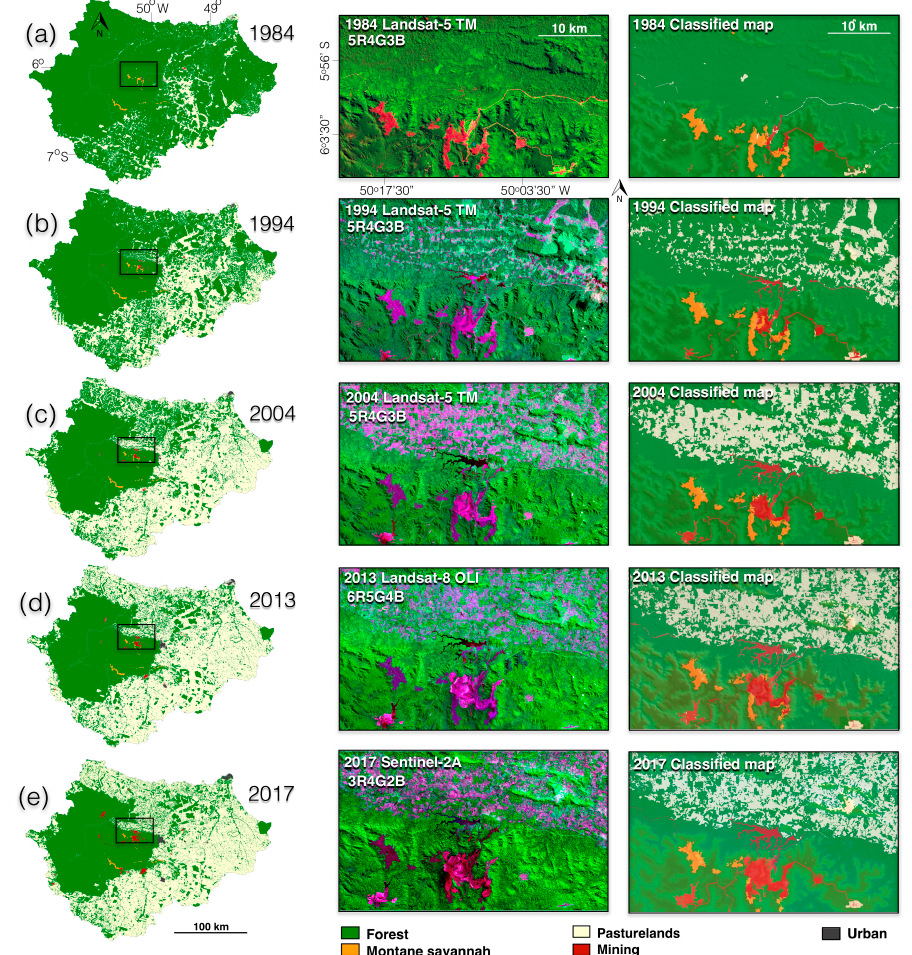
Figure 4. ( Left ) Classified Landsat images showing temporal and spatial variations in LCLU in the IRW for the years 1984 ( a ), 1994 ( b ), 2004 ( c ), 2013 ( d ), and 2017 ( e ) (modified from [20]). ( Center ) A specific site in the IRW illustrated from color composite Landsat images. ( Right ) Maps generated from GEOBIA.